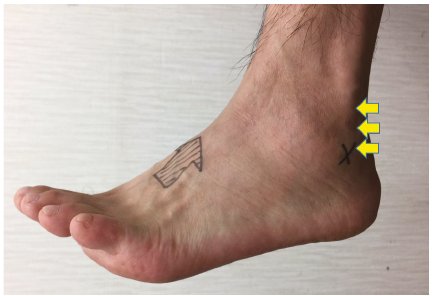
Figure 1: A solid mass 1 × 5cm in size was palpable over the retromalleolar portion of the left ankle along the course of the peroneal tendons (yellow